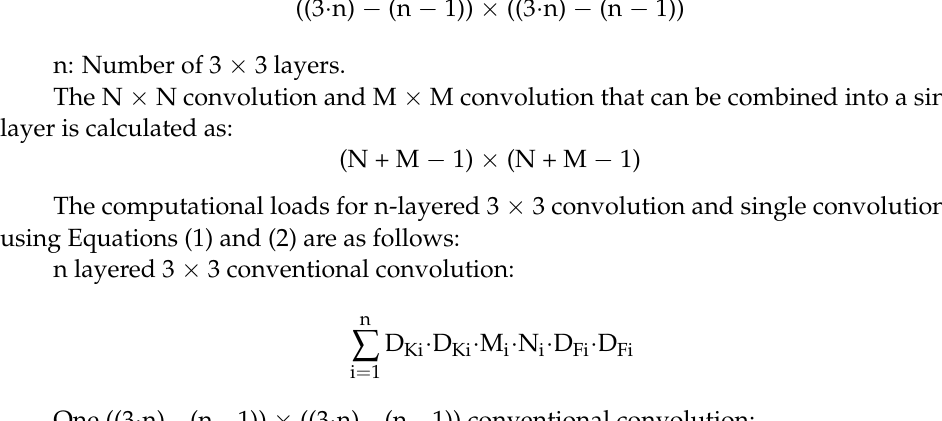
Figure 6. Convolution with a 2 × 2 kernel using convolutional stride 2 work on a 4 × 4 feature map. 4. Experiment Experiments were conducted to validate the proposed model. A model with the pro ‐ posed model ‐ switching architecture was constructed. We used VGG as the CNN classifier for model selection and the FCN for semantic segmentation.